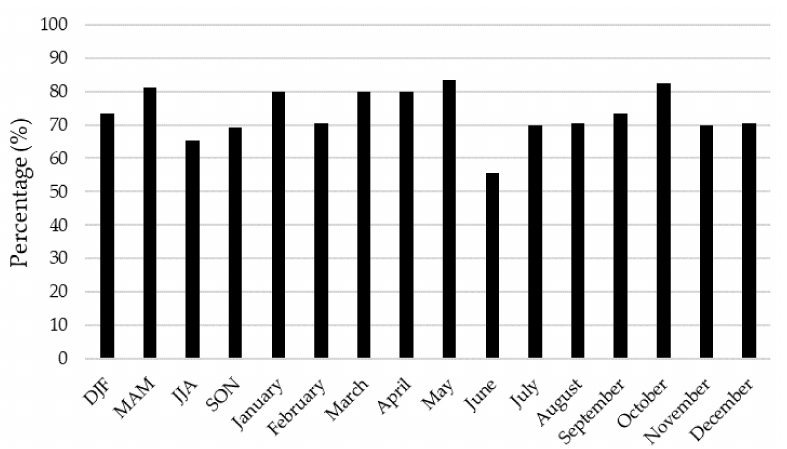
Figure 6. Response rate of streamflow to precipitation in the Muda River basin from 1985 to 2019.